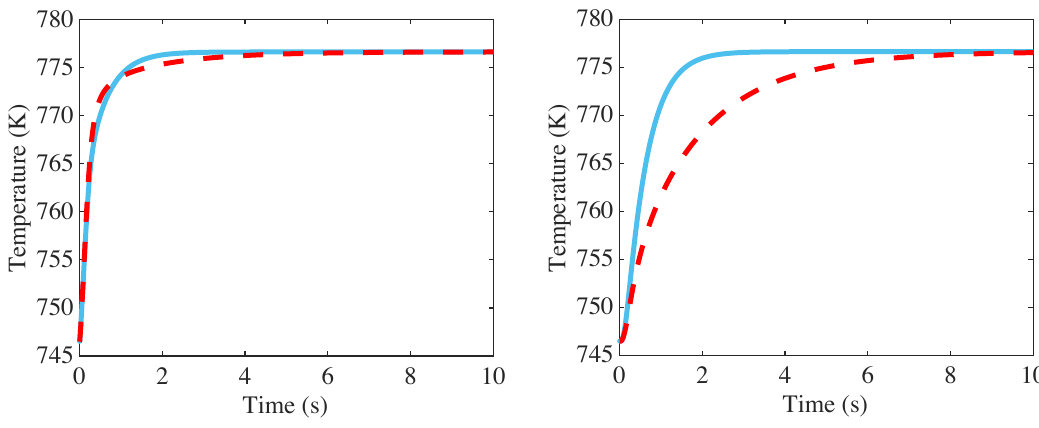
Figure 3. Outlet coolant temperature during the loss of flow event and overpower events. (left) Loss of flow. (right) Overpower. Metal fueled reactor results shown by blue line, MOX fueled reactor results by the red dashed